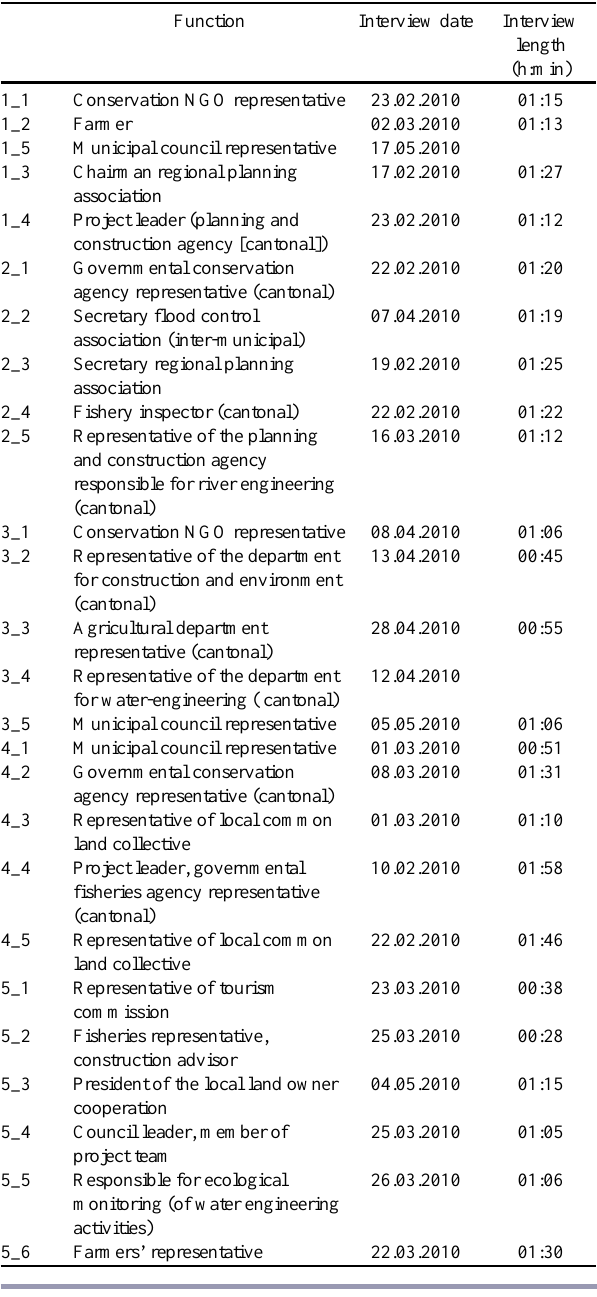
Table 2 . Interviewee numbers indicating planning cases (first digit) and the interviewee within the case (second digit), interviewee functions, date, and length of